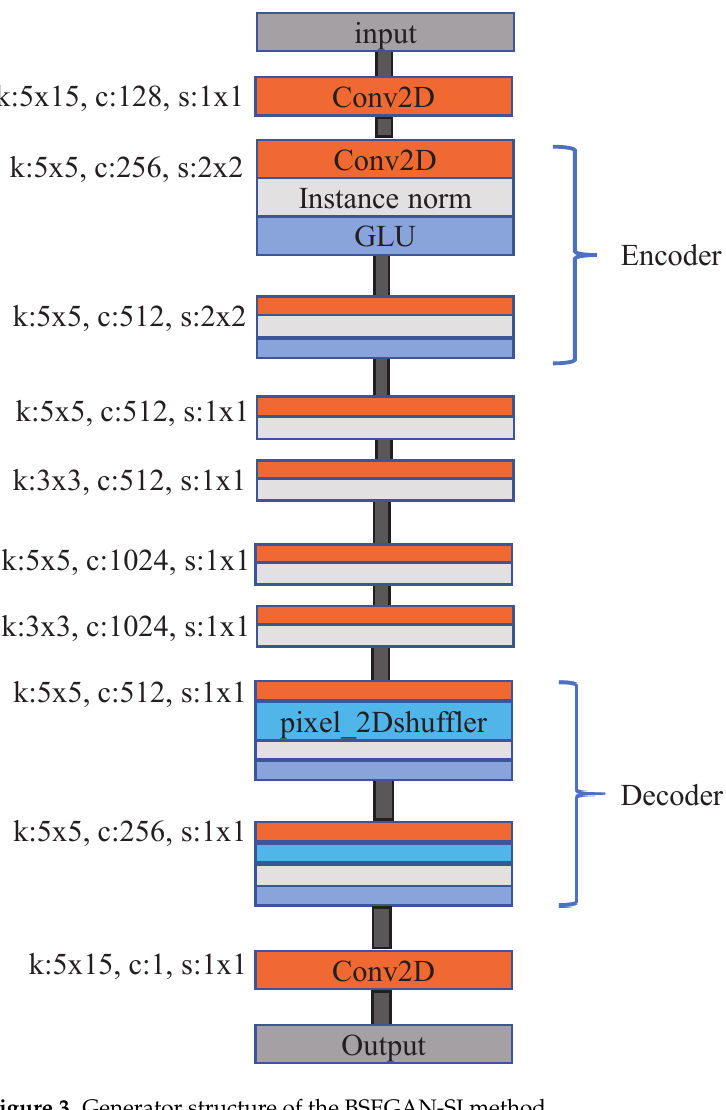
Figure 3. Generator structure of the BSEGAN-SI method.